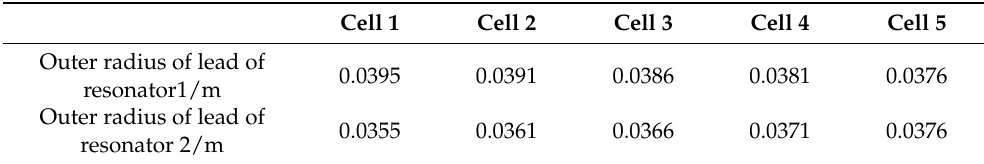
Table 4. Calculated parameters of the resonators in each cell.